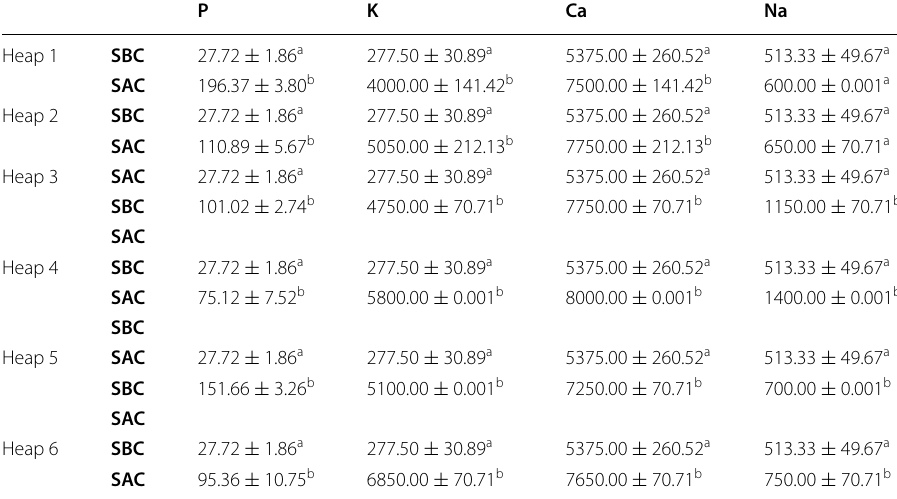
Legend: SBC , soil before composting [ t 0 ]; SAC , soil after composting. Values followed by the same letter are not significantly different ( p